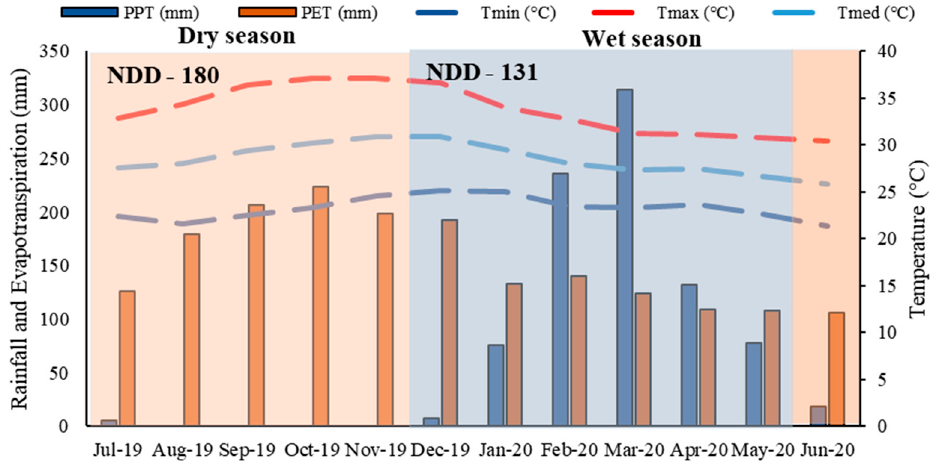
Figure 2. Mean rainfall; potential evapotranspiration; minimum, maximum and average tempera- tures; and average number of dry days for the wet and dry seasons in the study area from 1980 to 2020. PPT is the average monthly rainfall (mm); PET is the average monthly potential evapotranspiration (mm); Tmin, Tmax, and Tmed are the average monthly minimum, maximum, and mean temperatures (°C), respectively, for the study period; and NDD is the seasonal average number of dry days from 1980 to 2020.